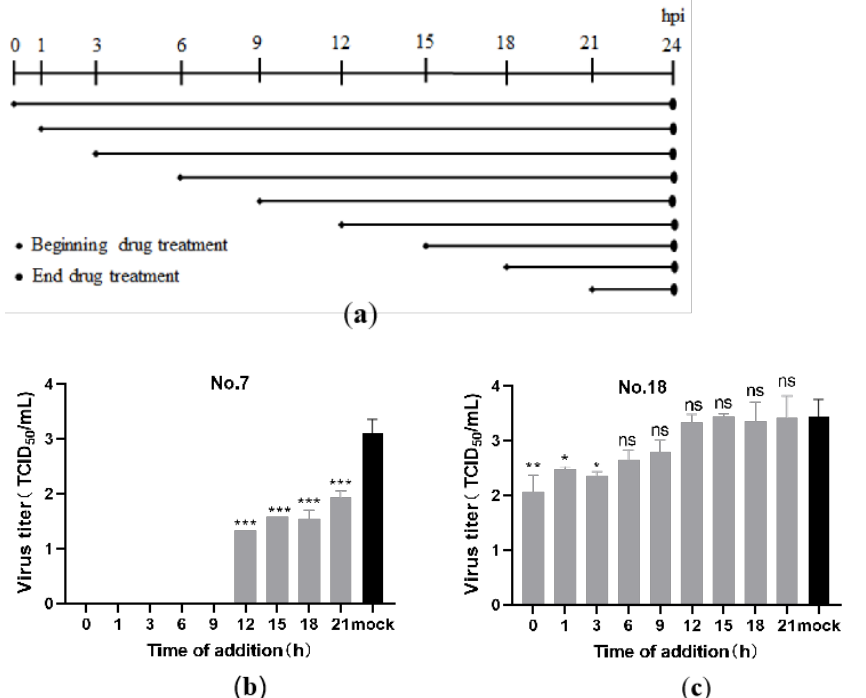
Figure 6. Effects of No.7 and No.18 carbazole derivatives on PEDV replication were time-dependent. ( a ) Schematic representation of carbazole derivatives treatment time. ( b , c ) Vero-81 cells were incubated with PEDV (MOI = 0.1) for 1 h, followed by treatment with 40 µM No.7 ( b ) or No.18 ( c ) carbazole derivatives at the indicated time (hpi). The viral titer in cell supernatant was detected by TCID 50 , and calculated by the Reed – Muench method. * p < 0.05; ** p < 0.01; *** p < 0.001.